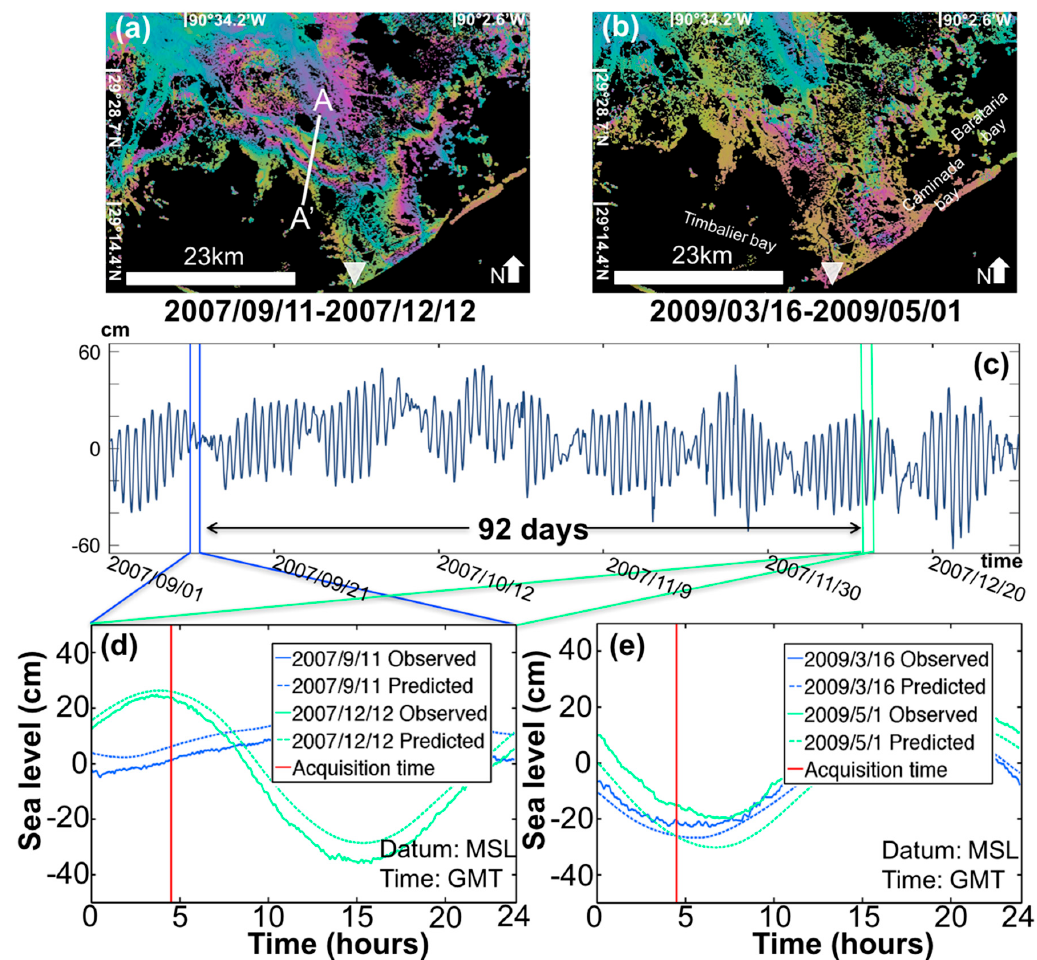
Figure 7. ( a ) ALOS interferogram of track 166 showing two fringe cycles across the tidal zone mapping the tide inundation extent. The white triangle marks the location of the Port Fourchon gauge station. The white line shows the location of the section described on Figure 7; ( b ) ALOS 16 March 2009–1 May 2009 interferogram of the same track showing no fringes; ( c ) Port Fourchon tide gauge data from 1 September 2007 to 31 December 2007. The blue and green vertical lines show the 24-h period recorded by the tide gauge for the two acquisition dates of interferogram ( a ); ( d ) Port Fourchon tide gauge predicted (solid) and observed (dashed) records plotted for 24-hour periods of the two acquisition dates (11 September 2007 in blue and 12 December 2007 in green). The red vertical line marks the ALOS acquisition time 4:32 GMT, which shows roughly 25 cm water level differences between the two acquisitions; ( e ) A similar tide gauge analysis for the two acquisition dates of the interferogram ( b ) showing only 5 cm of water level change between the two acquisition times.